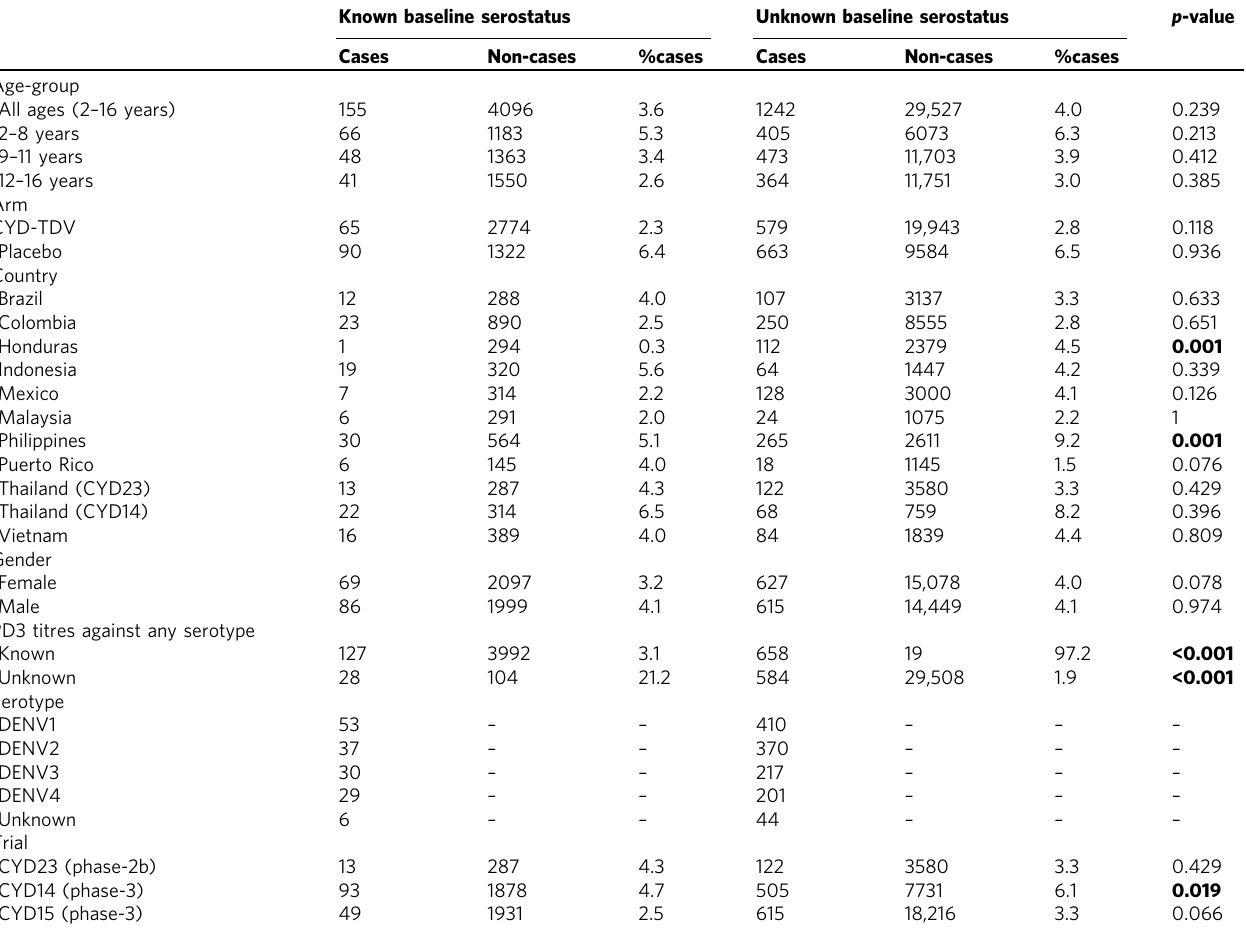
Table 2 Summary proportions of cases with known or unknown baseline serostatus across strati fi cations Known baseline